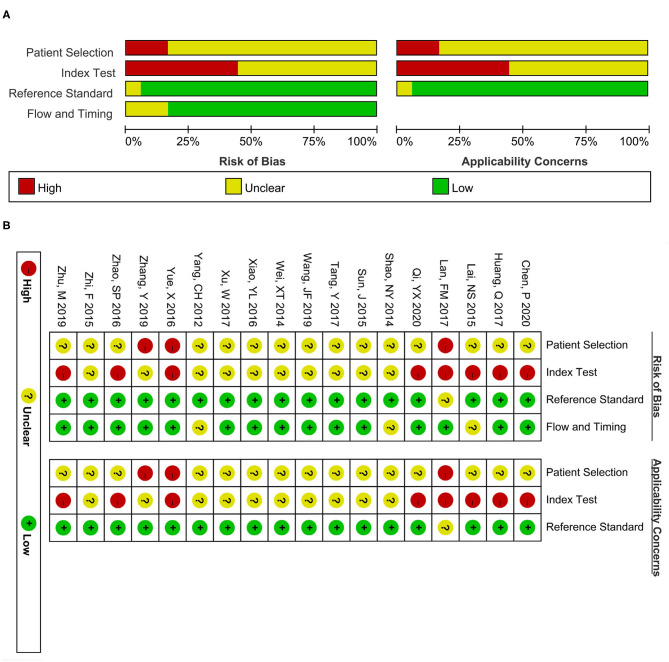
Quality assessment scale of the included studies. (A) Risk bias and applicability concerns graph. (B) Risk bias and applicability concerns summary. The red, yellow, and green colors separately present high, unclear, and low risk.